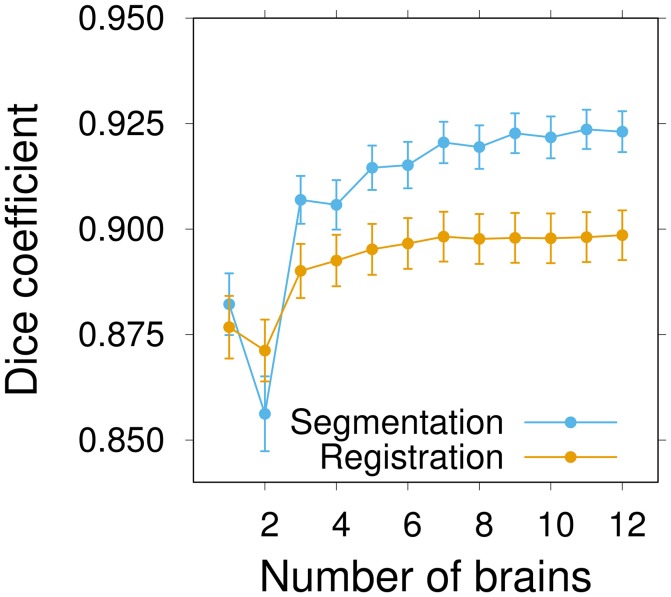
Influence of the number of brains on inter-sex atlas performance in segmentation and registration tasks. Group-wise inter-sex atlases were created with an increasing number of brains. Performance was quantified by computing the average Dice coefficient of segmented anatomical regions of male and female test brains after segmentation (blue) or registration (orange). Performance measures were averaged over 10 repeats. Error bars: s.e.m.